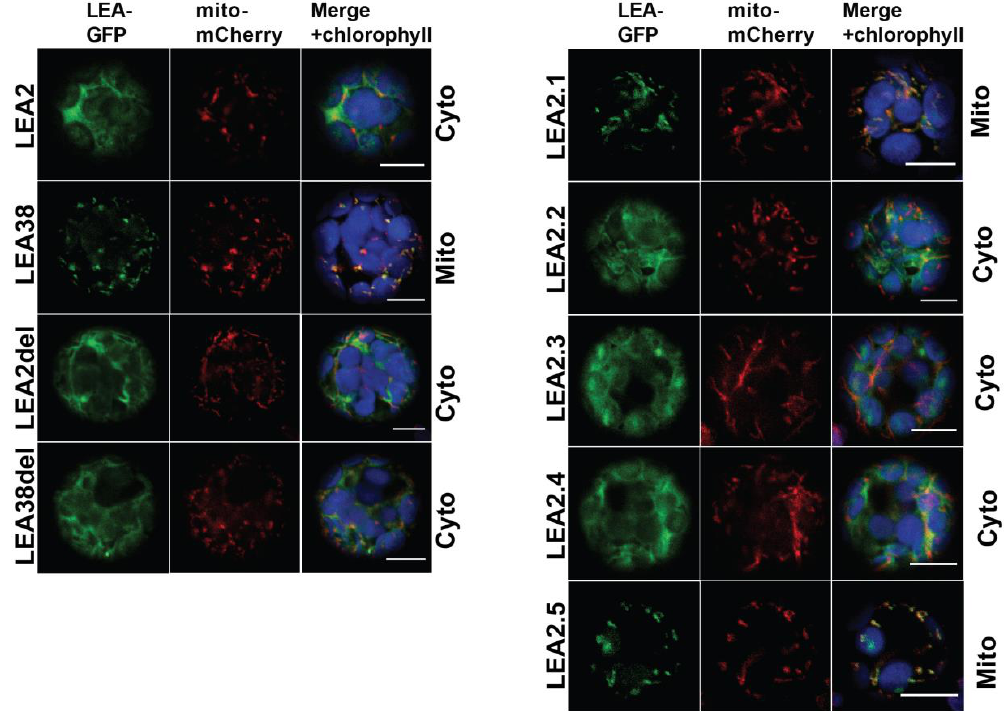
Figure 3. Impact of the mutations on the subcellular localization of LEA2-GFP and LEA38-GFP. The different proteins were expressed in fusion with GFP in Arabidopsis leaf protoplasts, using a line constitutively expressing a mitochondrial mCherry fluorescent protein. Observations were performed with a confocal microscope to visualize fluorescence from GFP, mCherry, and chlorophyll. First column: GFP, green fluorescence; second column: mCherry, red fluorescence; third column: merging of GFP and mCherry signals with chlorophyll autofluorescence in blue. Cyto, cytosolic; Mito, mitochondrial. Bars = 10 µm.